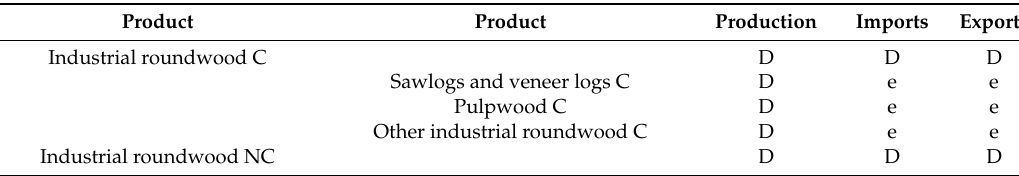
Table 1. Annual production and trade data used. D = Data given in FAO forest product